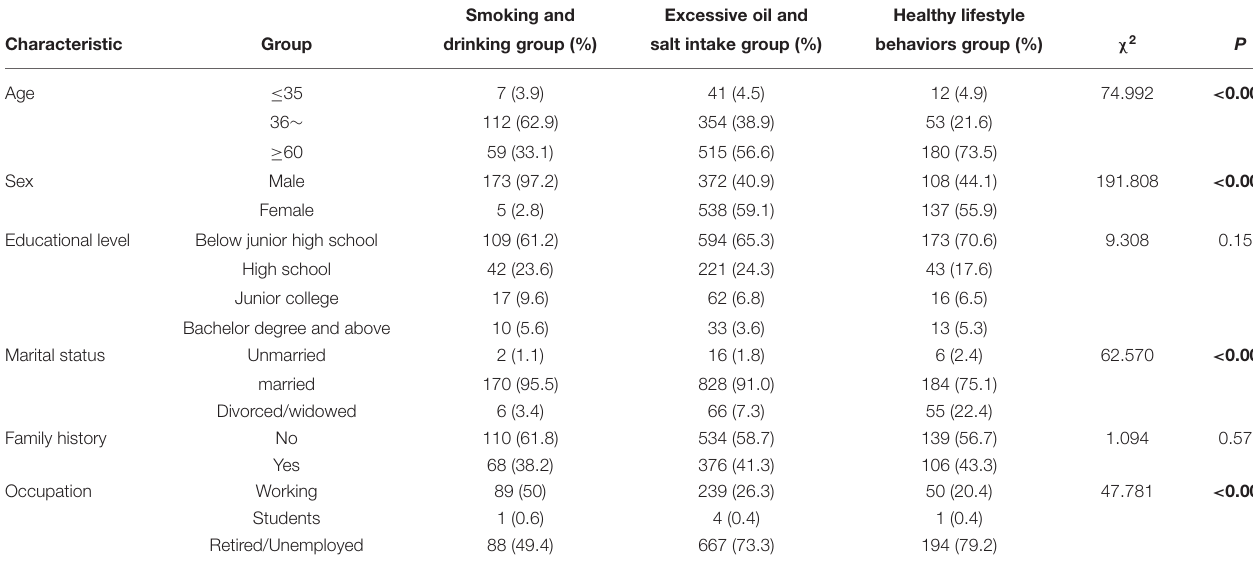
Boldface indicates statistical significance * P < 0.05.